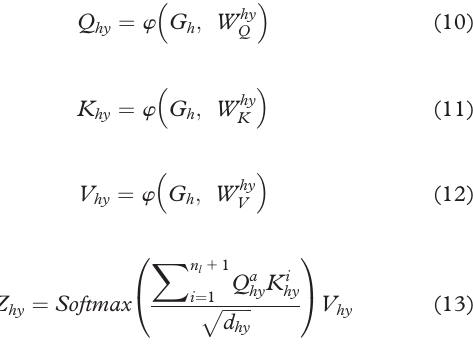
Algorithm 1: Interaction Feature Fusion